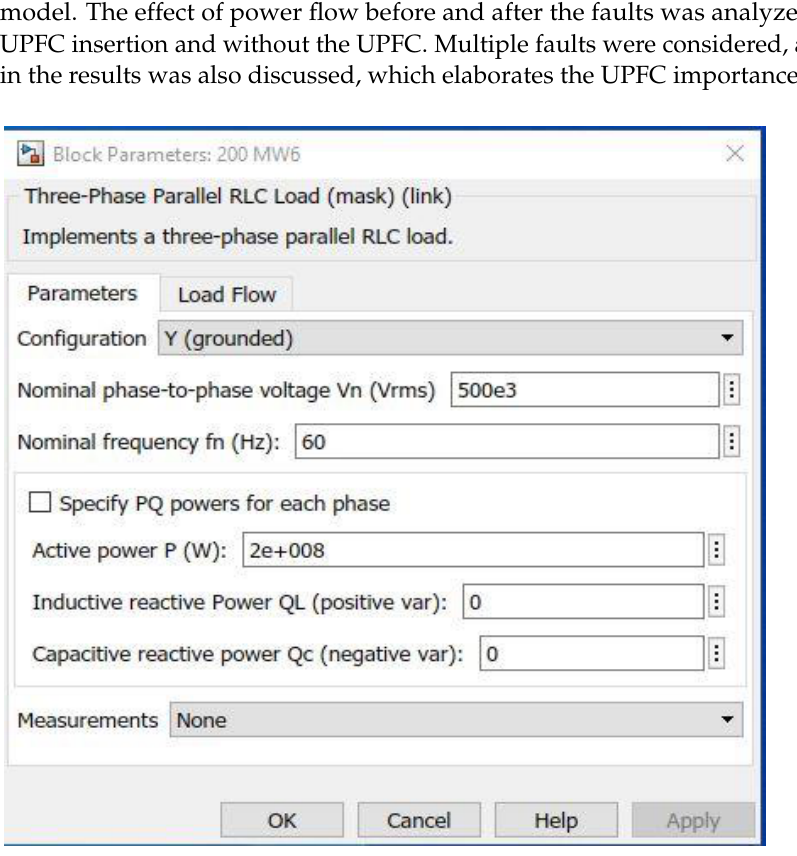
Figure 14. Parameters setting of 1000 MW Wind Farm Block.